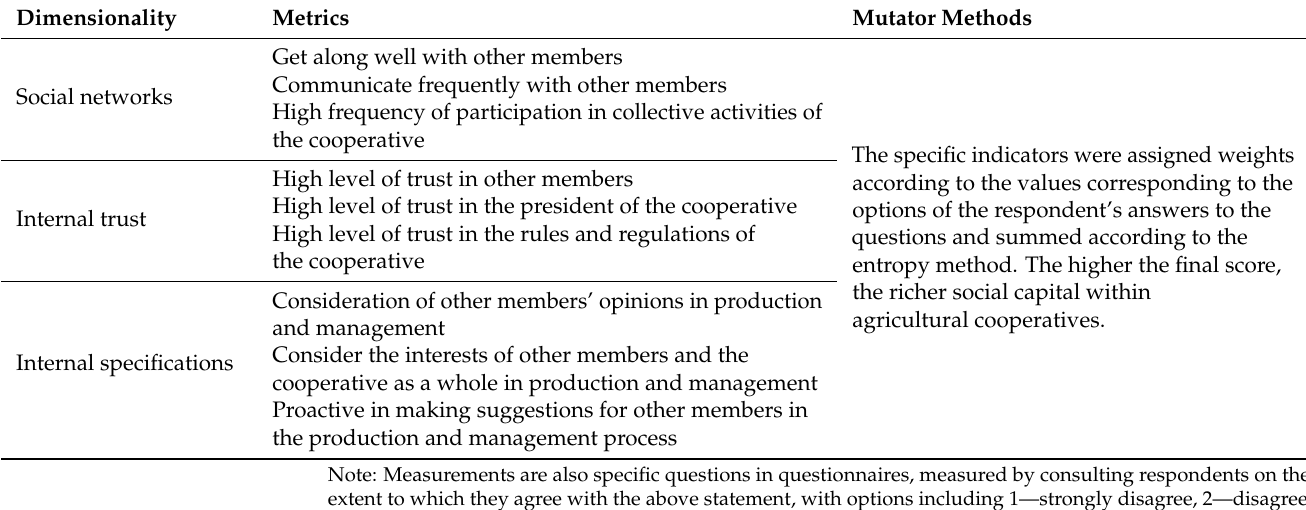
Table 1. Evaluation index of social capital within agricultural